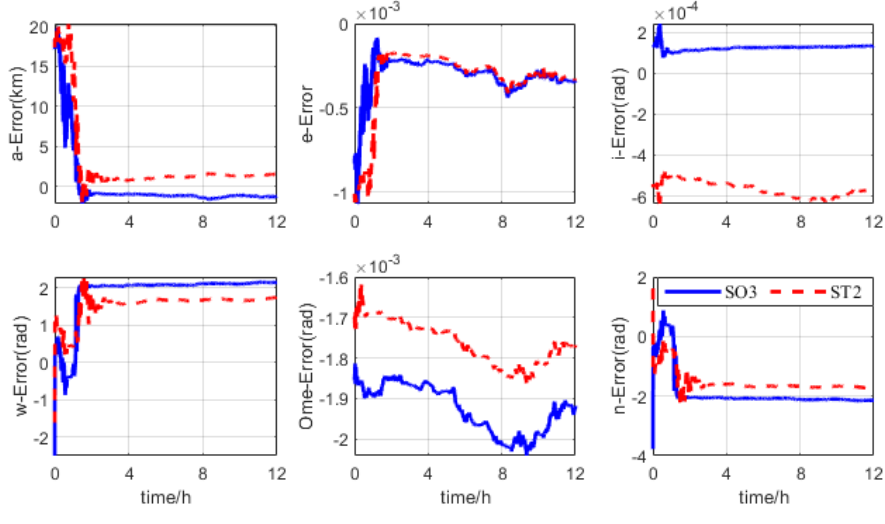
Figure 6. Estimation errors of orbit elements in the same circular orbit case.